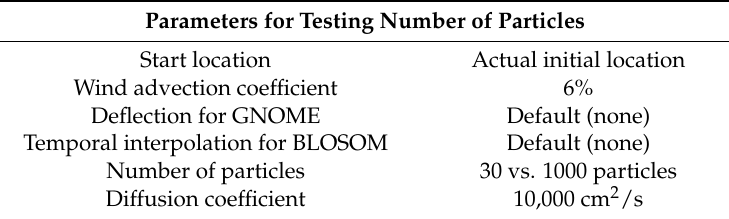
Table 11. Parameters for release period test.